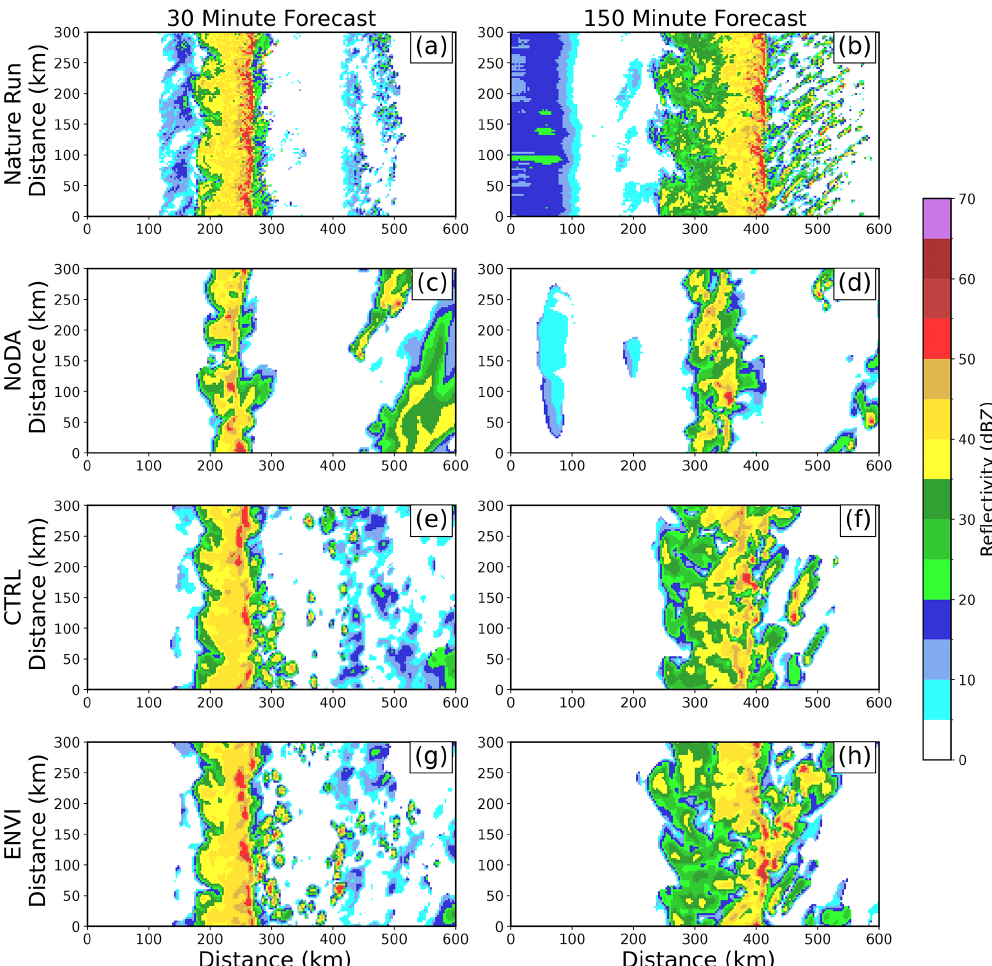
Figure 15. (a, b) Nature run and (c–h) forecast (member 25) Z at the lowest model level at (a, c, e, g) 30 and (b, d, f, h)